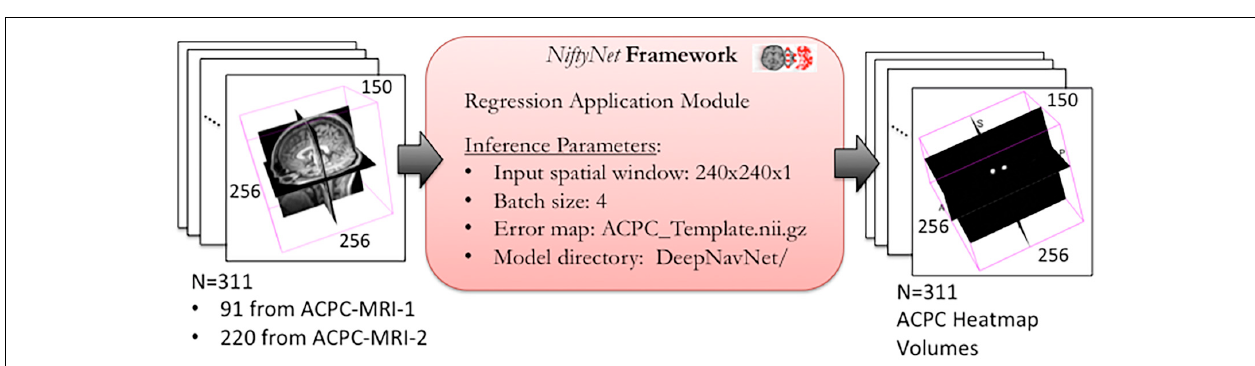
FIGURE 3 | DeepNavNet heatmap regression using NiftyNet Framework for test